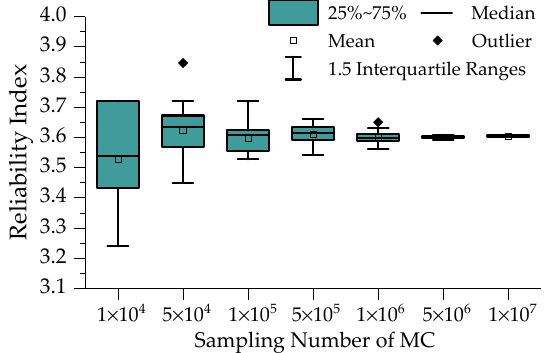
Figure 13. Boxplot of RI with different sampling numbers.